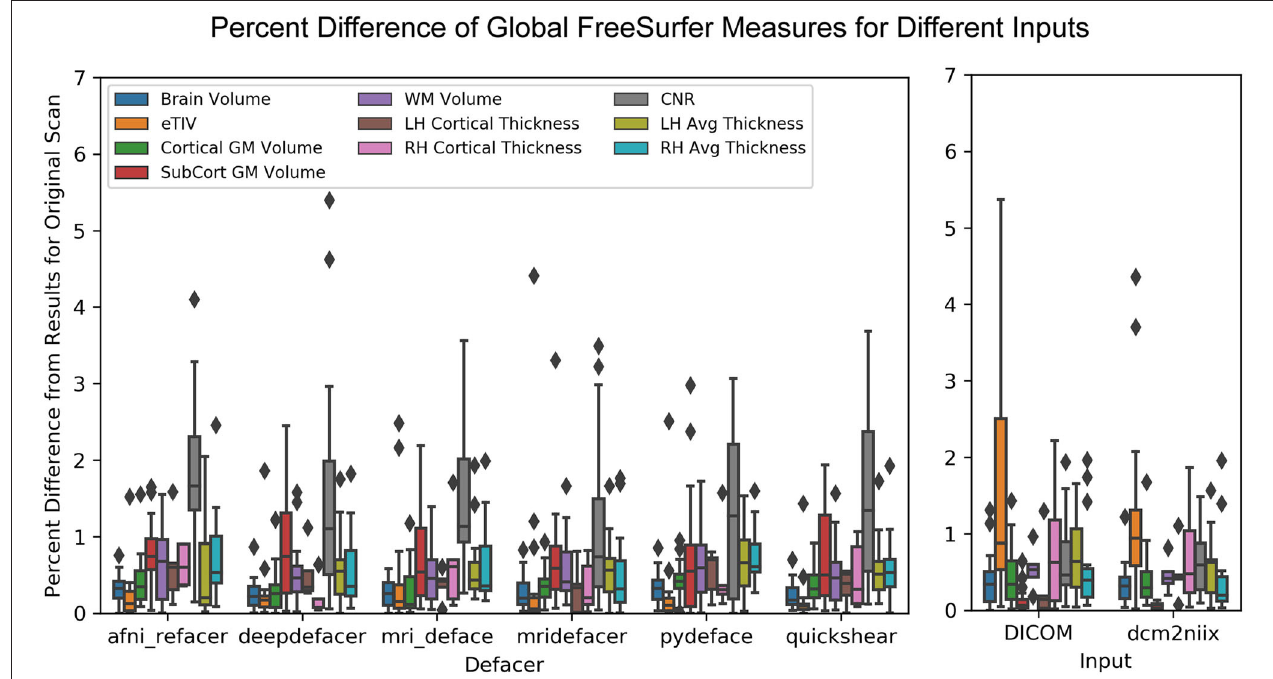
FIGURE 7 | Boxplot showing the percent difference between each of the defaced images and the original pre-defaced scan (left) for several global measures generated from the FreeSurfer pipeline, including total brain volume, estimated total intracranial volume (eTIV), cortical and subcortical gray matter volumes, white matter volume, average left and right hemisphere cortical thickness and the contrast-to-noise ratio (CNR) between cortical gray and white matter. These are compared to the variations in the same measures (right) with FreeSurfer output initialized with the original scan in different file formats (raw DICOM and NIfTI files converted using a different method).